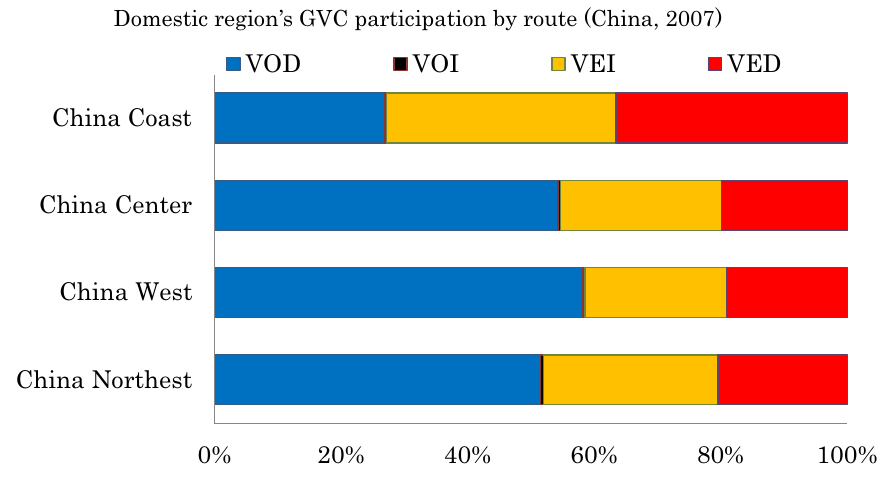
Domestic region’s GVC participation by route (China, 2007)